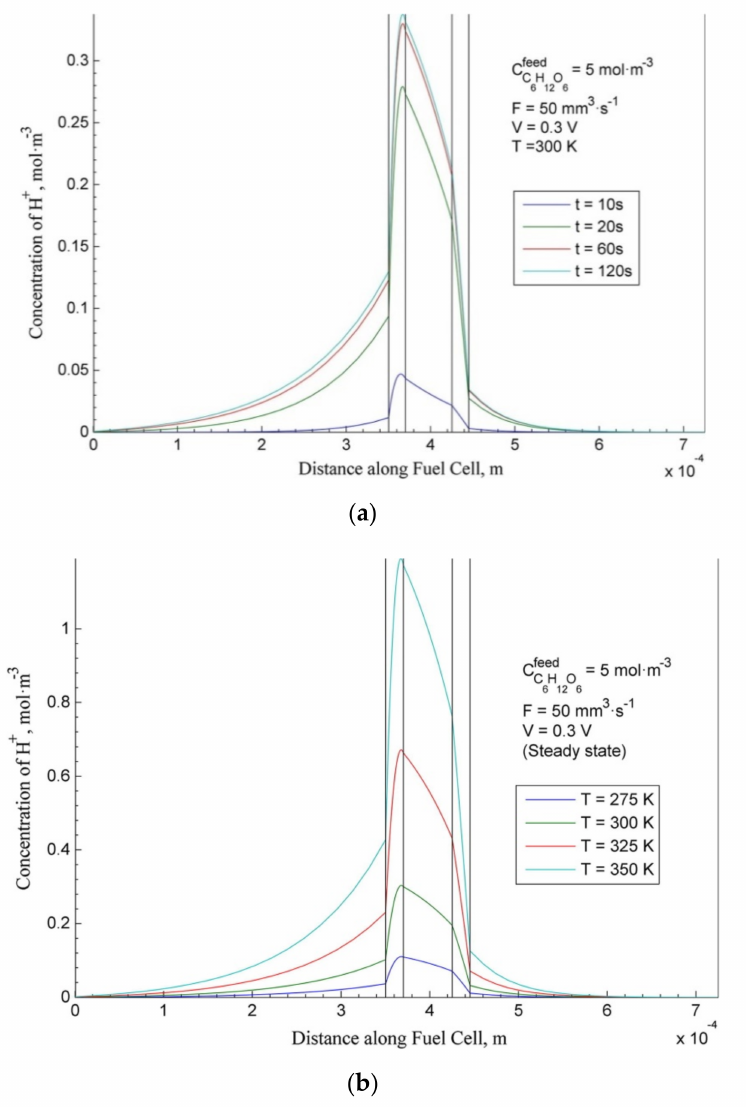
Figure 17. Variation of hydrogen ions concentration along the enzymatic cell as function of time ( a ) and temperature ( b ). Reprinted from [51], with permission from